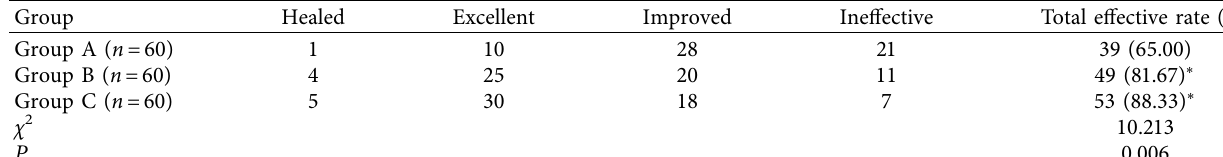
Table 3: Comparison of 3 groups of TCM score treatment efficiency ( n (%)).